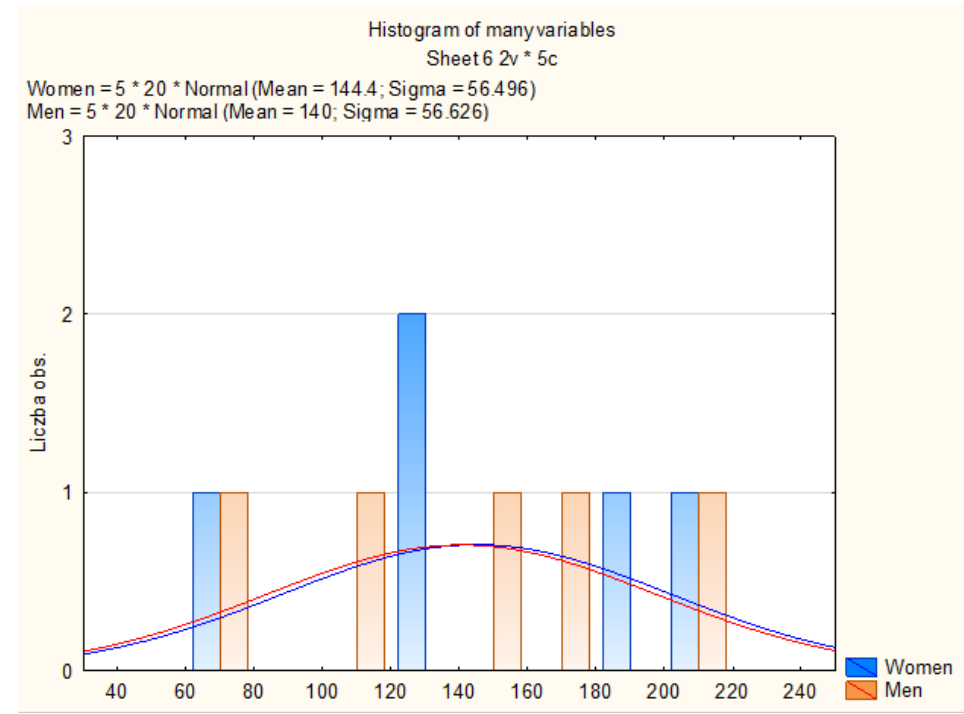
Figure 15. Employee structure by gender.